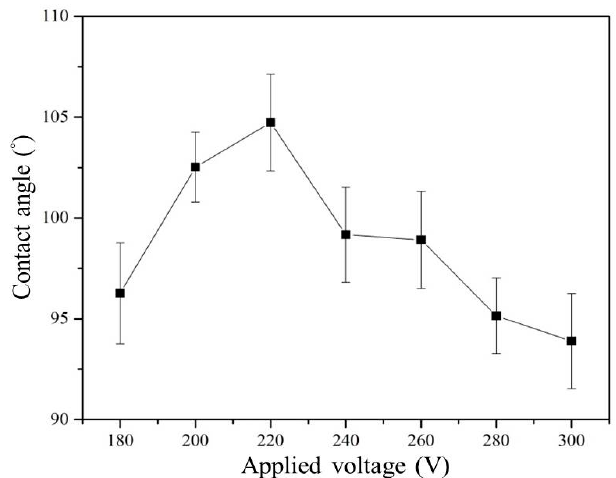
Figure 7. The contact angle mean and standard deviation values with respect to the applied voltage when the electrode distance of 20 mm and the cathodic specimen speed of 0.25 mm/s are fixed.